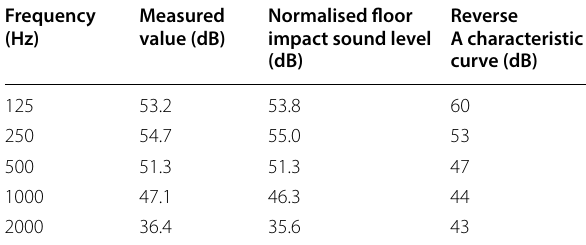
Table 3 Size of the receiver room.